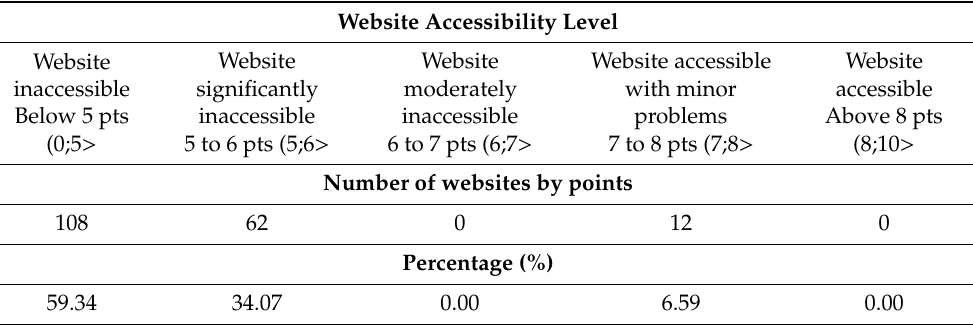
Table 3. Website accessibility level according to Utilitia.